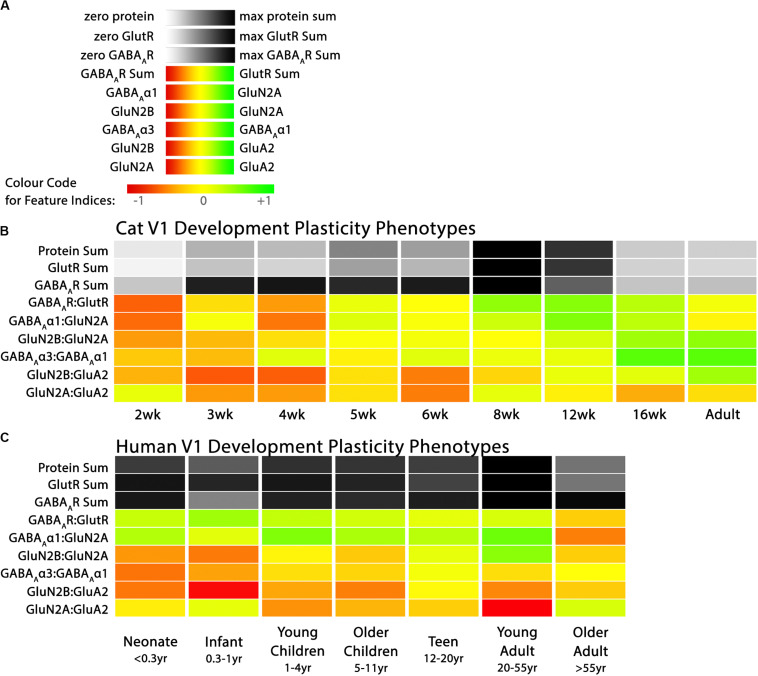
Plasticity phenotypes for cat and human V1 development. (A) The color-code for each of the nine plasticity features. (B) The developmental sequence of plasticity phenotypes in cat V1 was visualized as a stack of color-coded horizontal bars. The three gray-level bars represent the protein sums, and the six red-green color-coded bars represent the protein indices identified by the PCA. The plasticity phenotypes were calculated for each stage of cat V1 development and ordered from youngest to oldest [panels A, B reproduced from Balsor et al. (2019b), used with permission]. (C) The developmental sequence of plasticity phenotypes in human V1 was visualized as a stack of color-coded horizontal bars. The plasticity phenotypes were calculated for each stage of human V1 development and ordered from youngest to oldest. The color-coding conventions are the same as Figure 3B.